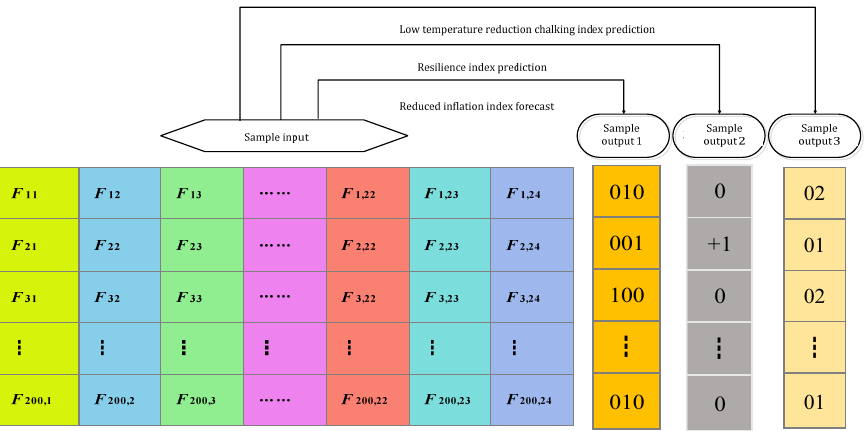
Figure 2. Initial sample structure for prediction of pellet metallurgical properties.